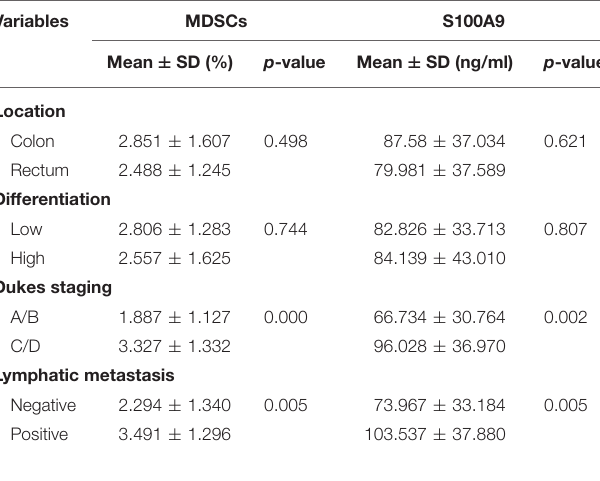
TABLE 2 | Relationship between MDSCs frequency or serum S100A9 levels and clinicopathological parameters of CRC patients.